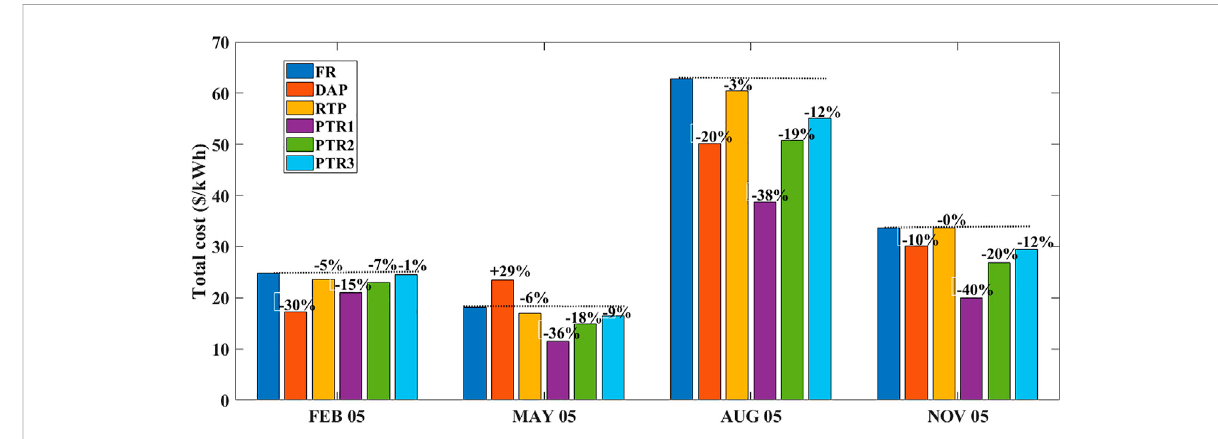
FIGURE 10 Percentage change in the total cost for all seasons and all pricing schemes.